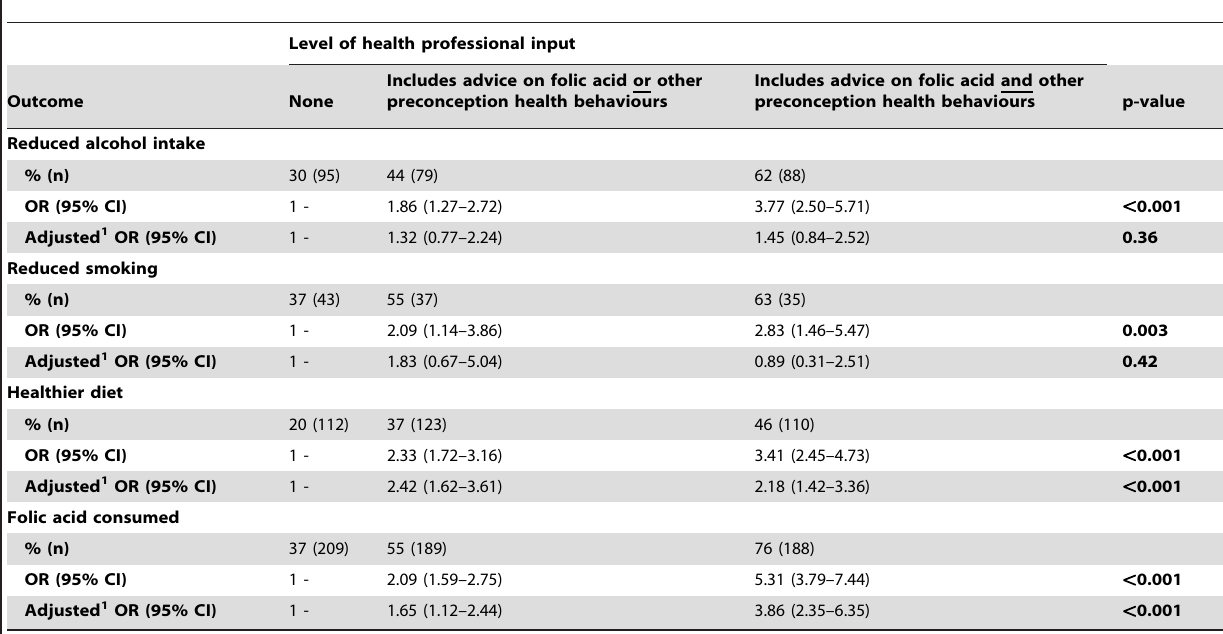
Table 4. Associations between health professional input and change in health behaviours before pregnancy and folic acid consumption.